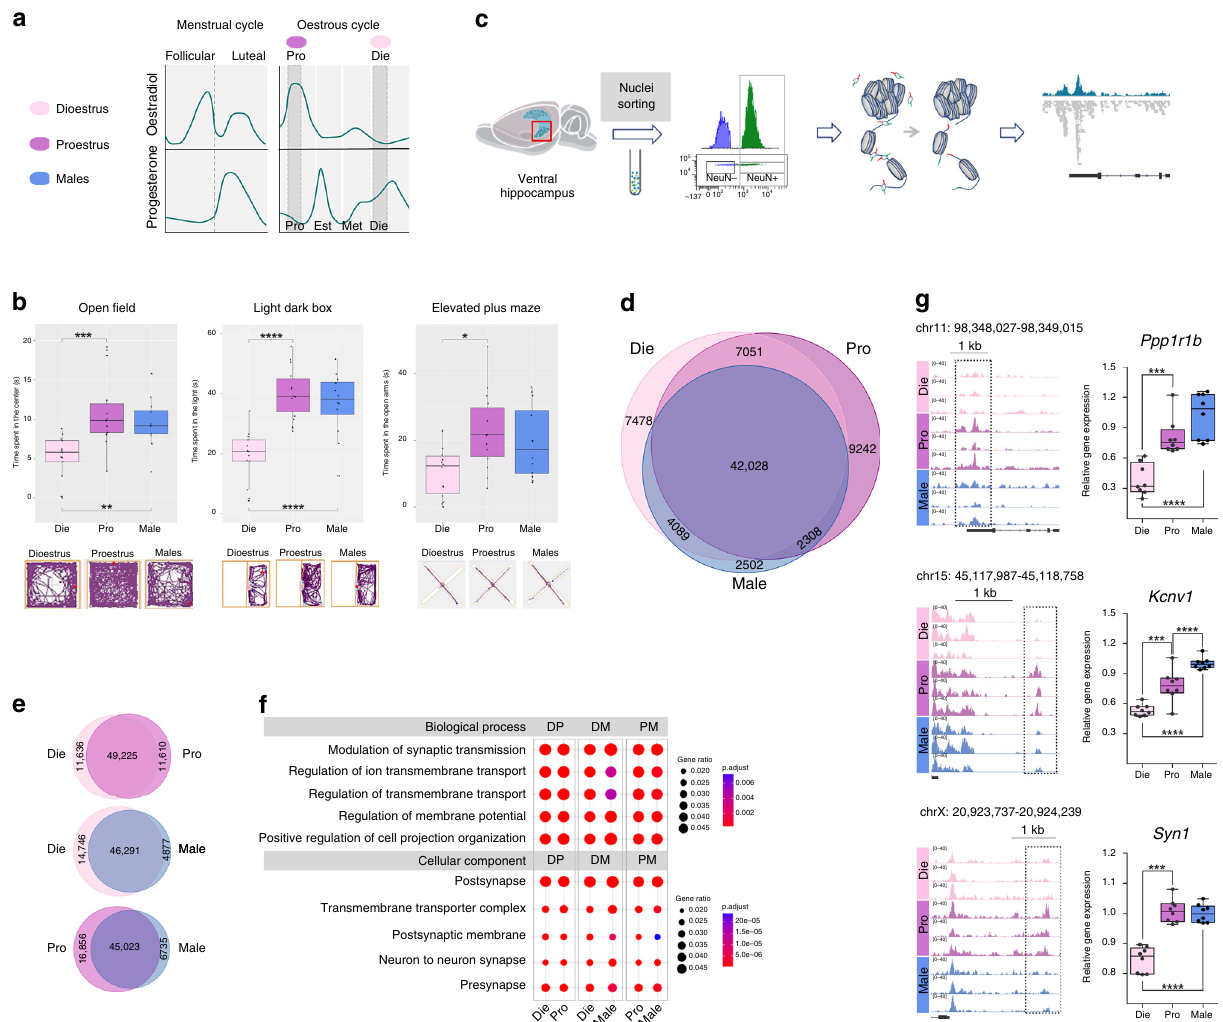
Fig. 1 Anxiety-like behaviour and neuronal chromatin organization fl uctuate across the oestrous cycle and differ between sexes. a Two stages of the oestrous cycle, proestrus (Pro, purple; high oestrogen – low progesterone) and early dioestrus (Die, light pink; low oestrogen – high progesterone) in mice mimic follicular and luteal phases in humans, respectively; Pro and Die females are tested with age-matched males (Male, blue) in all experiments. b Anxiety tests included: open fi eld (time spent in the centre); light – dark box (time spent in the light), and elevated-plus maze (time spent in open arms). Shown are individual data (box plots, n = 12 – 16 animals/group) and representative track plots. c Scheme of the ATAC-seq assay of FACS-puri fi ed neuronal nuclei from the ventral hippocampus. d Venn diagrams show the number of open chromatin regions (ATAC-seq peaks) in each group and their overlap ( n = 3 biological replicates/group). e Comparison of ATAC-seq peaks in Die vs. Pro, Die vs. Male, and Pro vs. Male. f GO analysis of genes showing differential chromatin accessibility between the groups: DP, Die-Pro comparison; DM, Die-Male comparison; PM, Pro-Male comparison. For each comparison, GO analysis was done twice: e.g. DP_Die represents genes with chromatin open in Die/closed in Pro; DP_Pro represents genes open in Pro/ closed in Die; colours indicate adjusted p- values and dot size indicates gene ratio; top fi ve GO terms for biological process and cellular component are shown. g Chromatin accessibility pro fi les of the Ppp1r1b , Kcnv1 and Syn1 promoters ( n = 3 biological replicates/group) and corresponding mRNA levels ( n = 8 animals/group). Shown are genomic coordinates of differential ATAC-seq peaks and their distance to the TSS. Box plots (box, 1st – 3rd quartile; horizontal line, median; whiskers, min/max); * p < 0.05; ** p < 0.01; *** p < 0.001; **** p < 0.0001 (one-way ANOVA with the Tukey ’ s post hoc activated nuclei sorting, using an antibody against the neuronal We found 50,000 – 60,000 open chromatin regions in each nuclear marker NeuN, and allowed a high-resolution, cell-type- group — dioestrus, proestrus and males — with the majority speci fi c chromatin accessibility pro fi ling. The ATAC-seq assay is (42,028, 69.3 – 82.5%) regions in common to all groups (Fig. 1d). based on the activity of the enzyme Tn5 transposase, which cuts A smaller number (7478 regions) was speci fi c to dioestrus, a DNA and inserts sequencing adapters into open genomic regions, comparable number (9242 regions) speci fi c to proestrus and only allowing the genome-wide identi fi cation of DNA elements 2502 regions were speci fi c to males (Fig. 1d). Remarkably, 32.1% located at sites of open chromatin. Following ampli fi cation, of the regions showed differential chromatin accessibility between sequencing and bioinformatic analysis of the accessible DNA, dioestrus and proestrus females (Fig. 1e; Supplementary Data 1), each open chromatin region is detected as an enrichment signal implying that hippocampal neuronal chromatin undergoes or peak (Fig. 1c). We considered only high-con fi dence peaks signi fi cant reorganization during the few days of the oestrous which were detected in at least two out of three biological cycle. This within-female chromatin variability was found to be of replicates per each group. a similar extent as between-sex variability, as we found that 29.8%